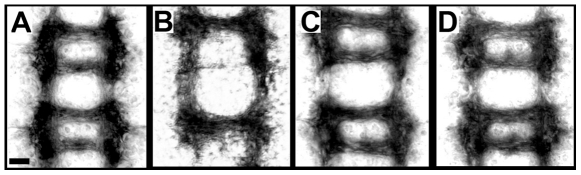
Rescue of the CNS phenotype of gsb mutant embryos by gsb-Prd and gsb-Pax3 transgenes.Patterns of longitudinal and commissural axons in the CNS of wild-type (ry506; A) and Df(2R)IIX62/gsb525 embryos without (B) and with one copy of the gsb-Prd (C) or gsb-Pax3 transgene (D). Embryos at stage 15 were collected from crosses between Df(2R)IIX62/CyO, hb-LacZ; gsb-Prd/+ or Df(2R)IIX62/CyO, hb-LacZ; gsb-Pax3/+ males and gsb525/CyO, hb-LacZ females, and double stained with rabbit antiserum against ß-galactosidase and monoclonal antibody BP102. One quarter of the embryos did not stain for ß-galactosidase as expected. Half of these embryos have missing or reduced posterior commissures as expected for gsb mutants, the other half displays fully rescued commissural patterns as in wild-type embryos. Scale bar: 10 um.